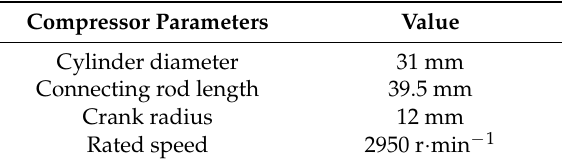
Figure 7. Schematic of the modified compressor.